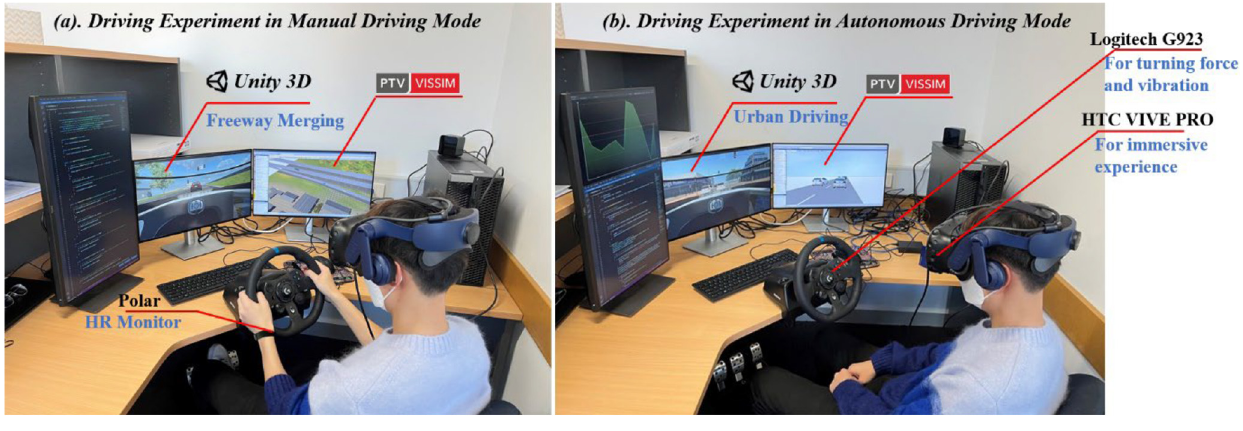
Figure 5 Human-in-the-loop experimental